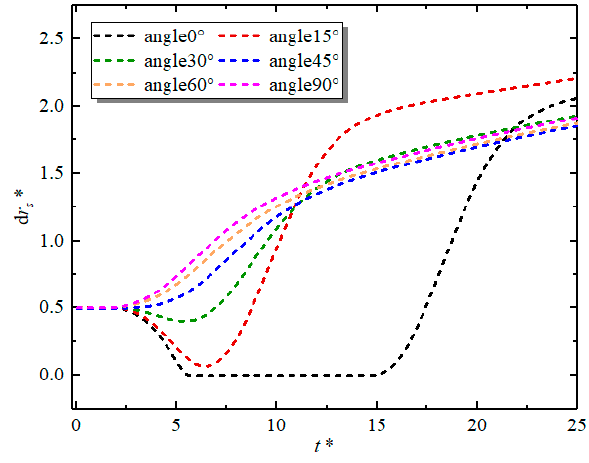
Figure 11. Dimensionless surface-to-surface distance of particles released with different initial angles as functions of dimensionless particle settling time.